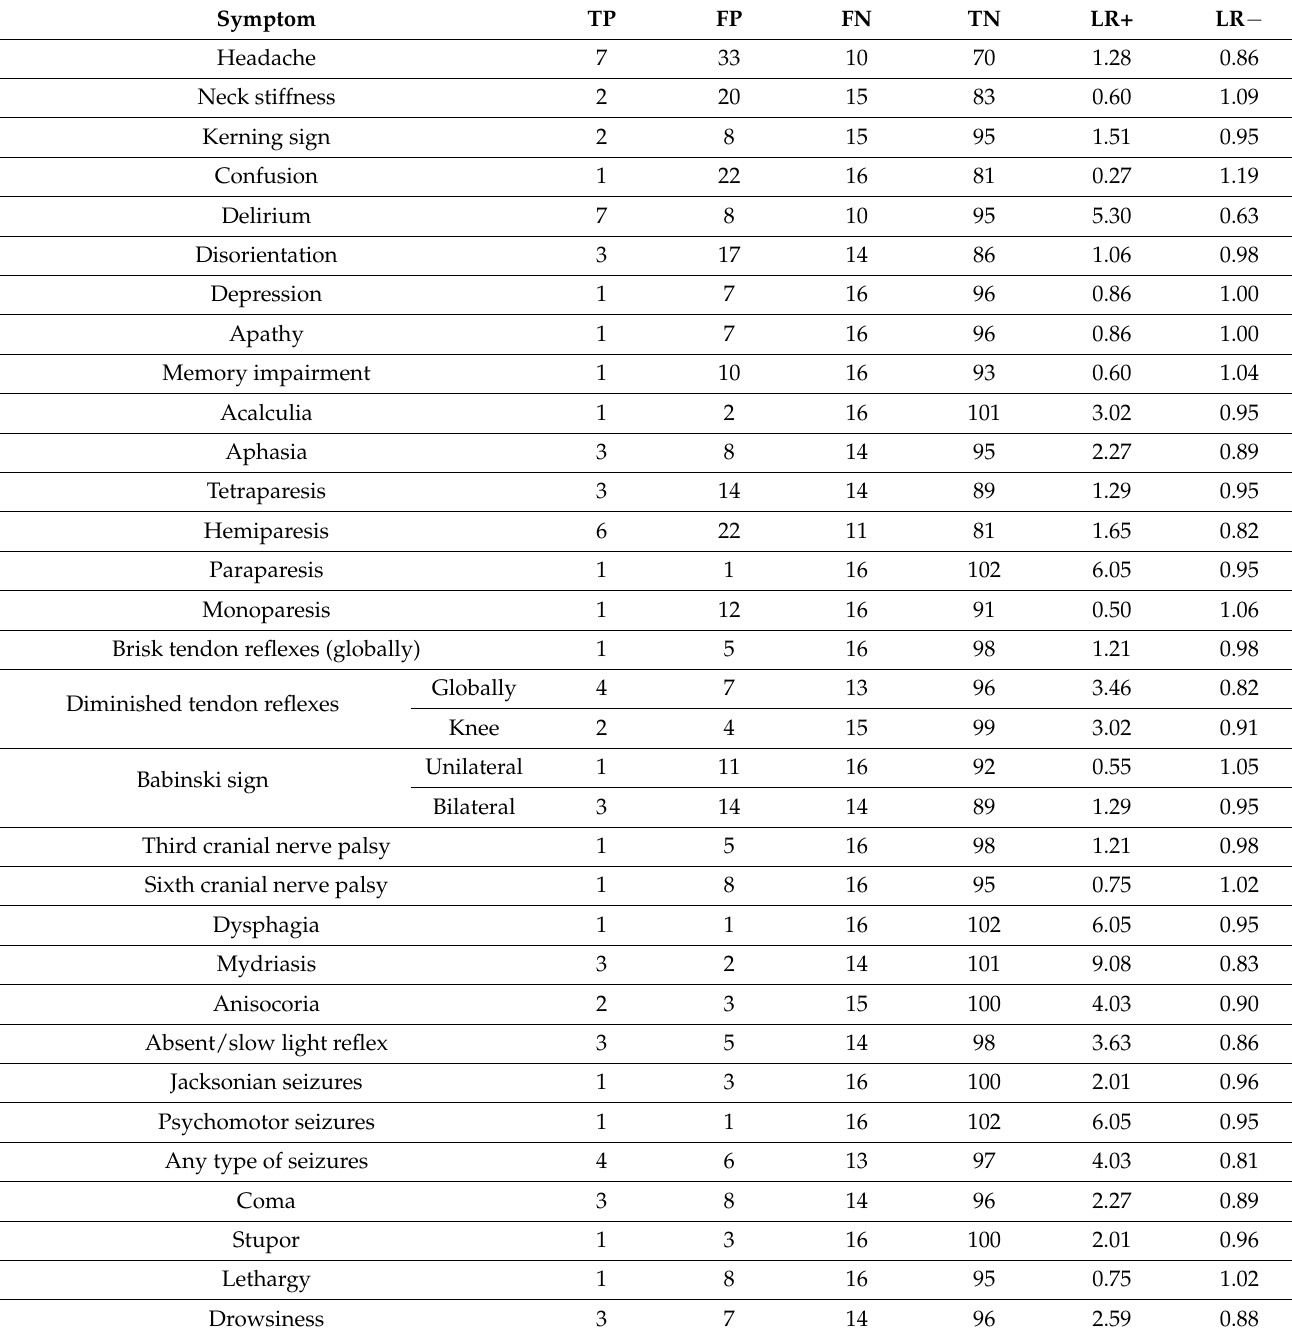
Table 4. Data on the probability of a severe CNS infection (with outcome death) based on likelihood ratios of clinical neurologic